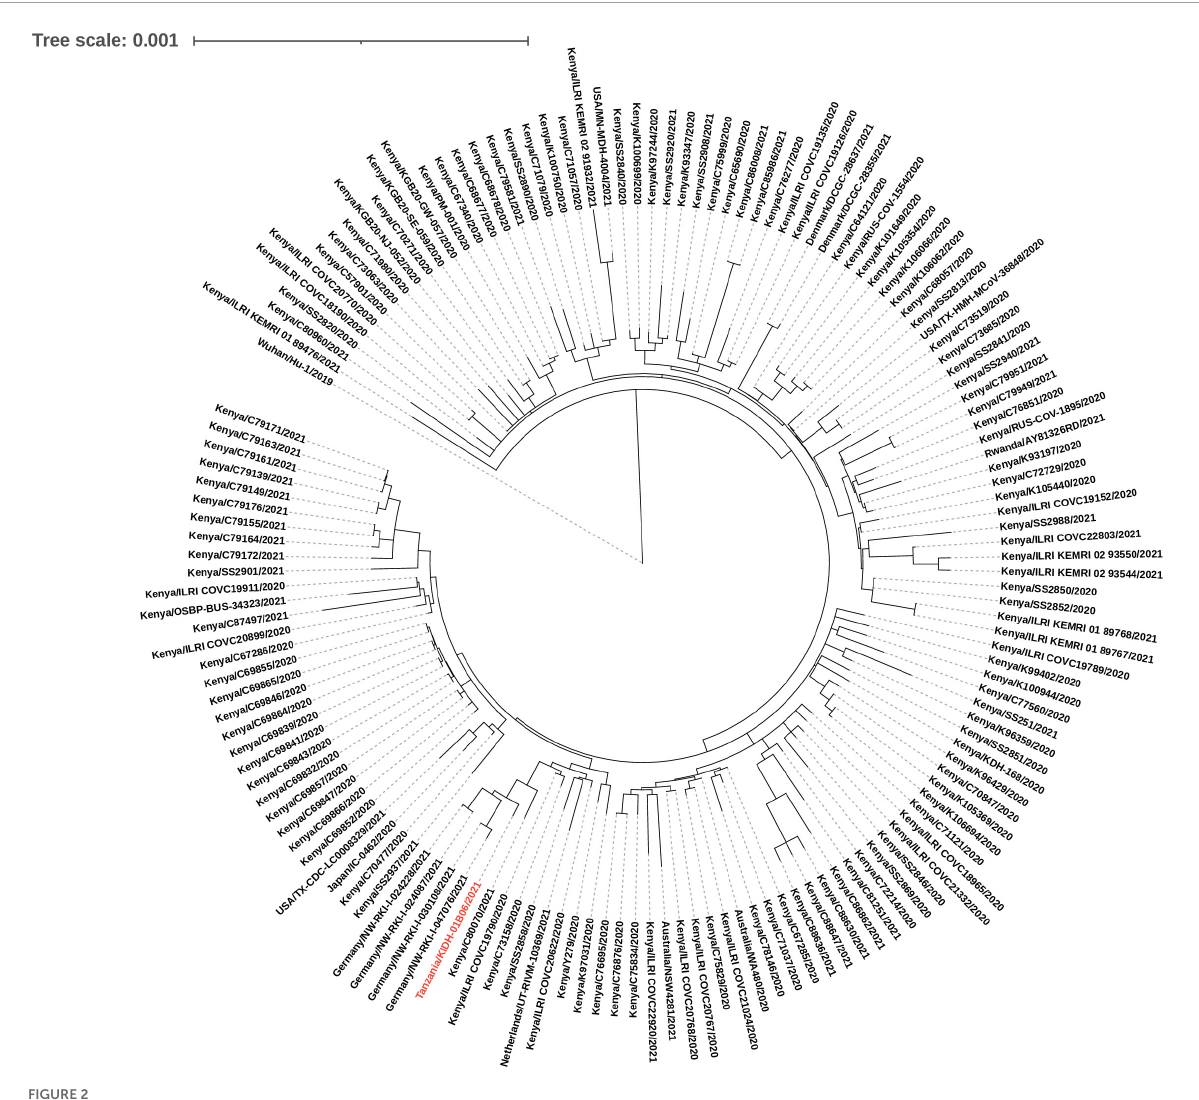
FIGURE2 A maximum likelihood phylogenetic tree of B.1.530 lineage placed against 150 global genomes belonging to B.1.530 lineage. Isolate Tanzania/KIDH-01B06/2021 is colored red.